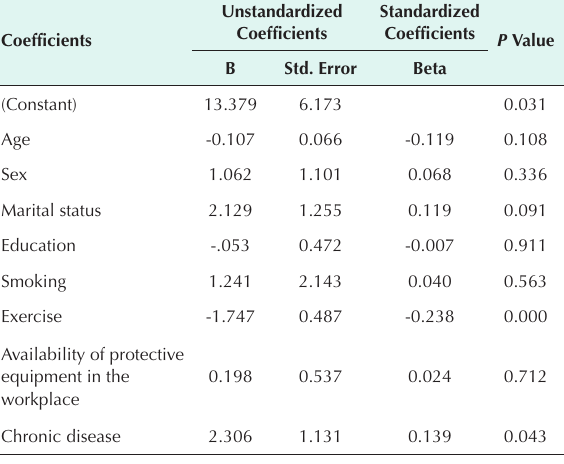
Table 3. Coefficients of Regression Model to Predict the Level of Anxiety